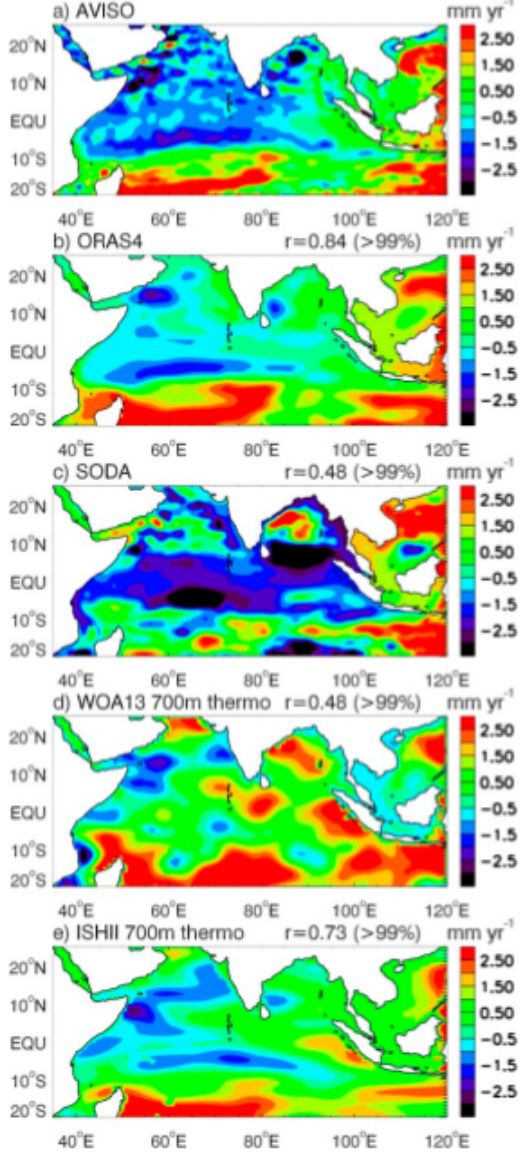
Figure 3. The linear trend map of sea level (mm year − 1 ; global mean SLR removed) over the Indian Ocean from 1993–2010, when all datasets are available. ( a ) The French Archiving, Validation, and Interpolation of Satellite Oceanographic Data (AVISO) satellite altimeter data; ( b ) ORAS4 reanalysis; ( c ) SODA reanalysis; ( d ) WOA13 upper 700 m thermosteric sea level; ( e ) Ishii upper 700 m thermosteric sea level. Spatial pattern correlation coefficient between AVISO and each product is also plotted, with r = 0.84 for AVISO/ORAS4, 0.48 for AVISO/SODA, 0.48 for AVISO/WOA13, and 0.73 for AVISO/Ishii, with all coefficients exceeding 99%